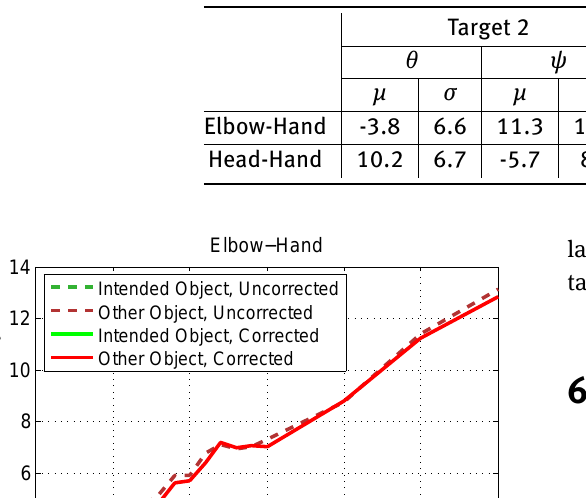
Table 2: µ and σ of angular errors (in degrees) are given for Target 2 and across all targets. Error statistics of Table 2 was used for the object separation evaluation. The reader is referred to [81] for the complete table.